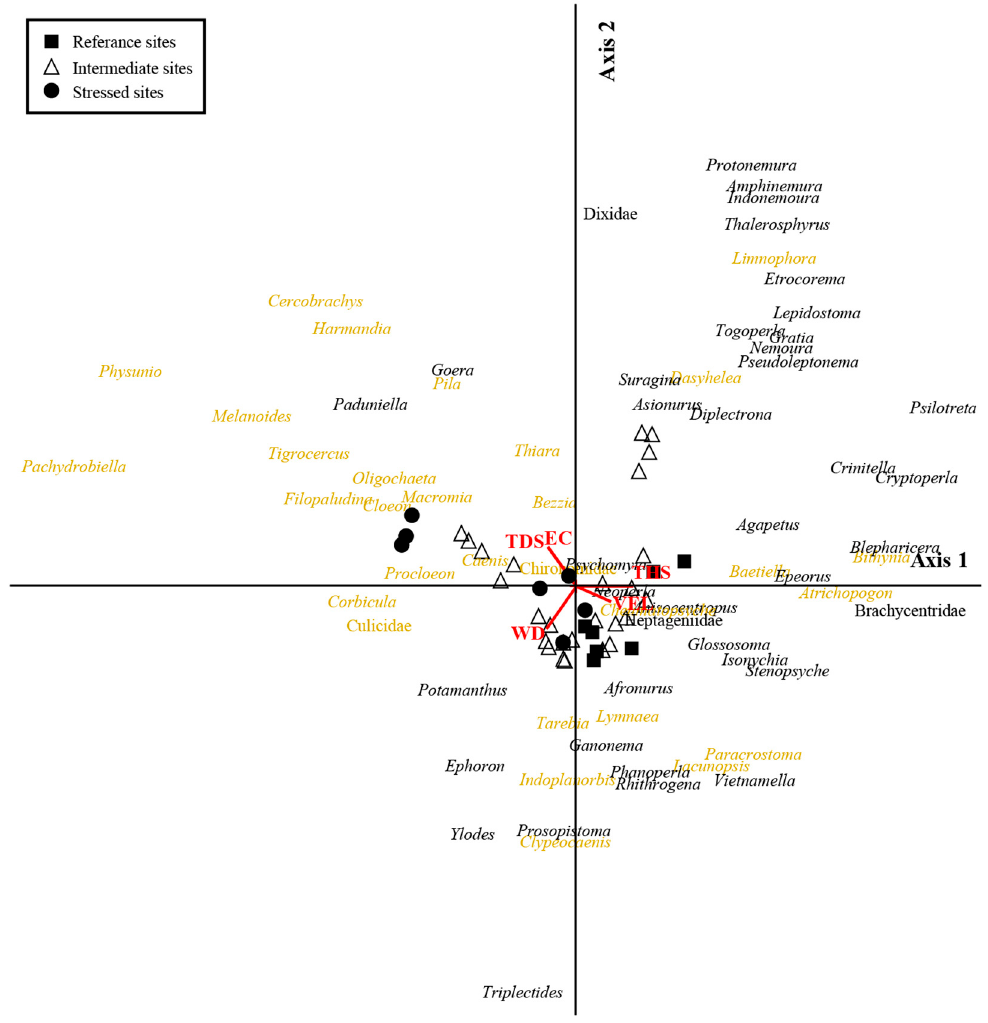
Figure 3. CCA ordination analysis showing the association between environmental variables and benthic macroinvertebrate abundance in the reference, intermediate, and stressed sites. Black color denotes intolerant taxa; yellow denotes moderate and tolerant taxa.